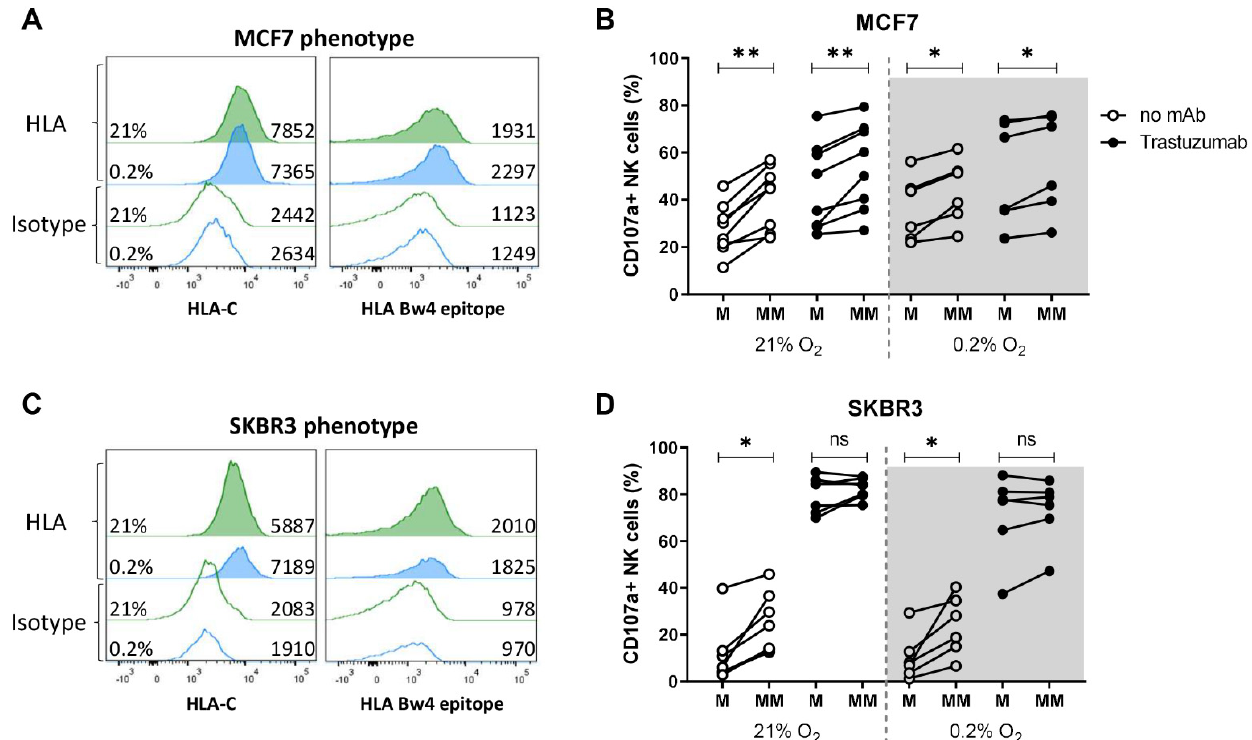
Figure 4. NK cell degranulation of KIR-ligand-matched and KIR-ligand-mismatched NK cells in response to breast cancer cells under normoxia or hypoxia with or without trastuzumab. ( A , B ) MCF7 and SKBR3 cells were exposed to 21% O 2 or 0.2% O 2 for 16 h and stained for HLA surface expression by flow cytometry. Histograms from normoxic conditions are indicated in green, with hypoxic conditions in blue. ( C , D ) Degranulation assays were performed by co-culturing NK wells either with MCF7 or SKBR3 target cells with or without trastuzumab for 4 h at 21% O 2 or 0.2% O 2 . Based on the KIR expression of NK cells and HLA expression of target cells, KIR-ligand-matched (M) and -mismatched (MM) NK cell subsets were analyzed and the percentage of degranulating NK cells is shown per subset as % CD107a + NK cells. Each dot represents the average of duplicates from one NK cell donor. * p < 0.05, ** p < 0.01, ns = not significant.